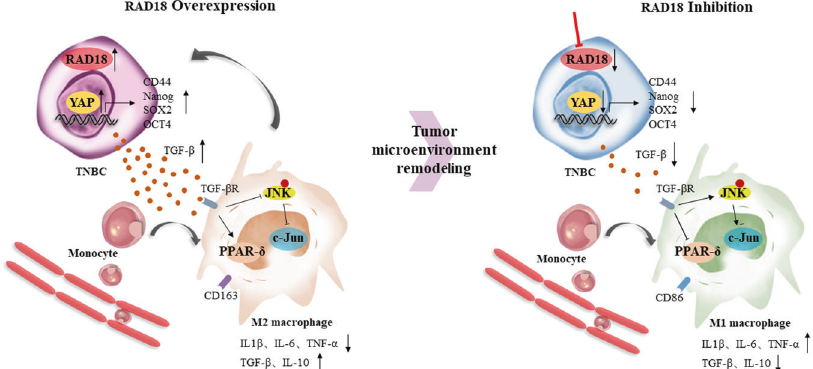
Fig. 7 The schematic diagram of the underlying mechanisms described in our study. A positive feedback loop: RAD18-YAP-TGF- β between triple-negative breast cancer and macrophages regulates cancer stemness and progression.